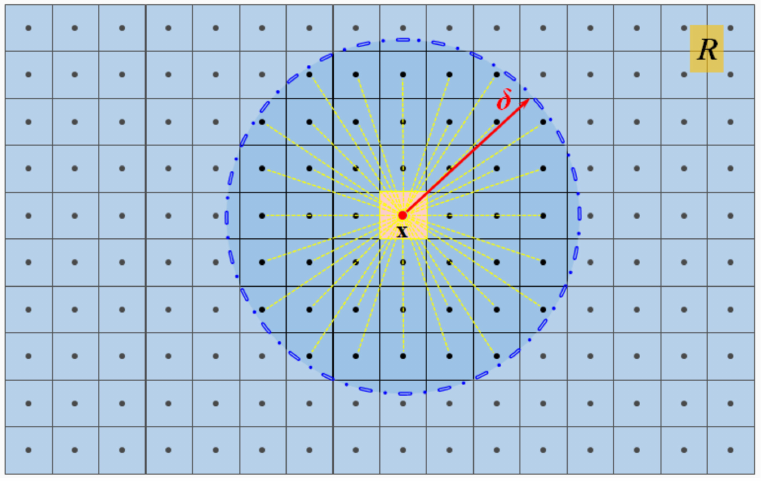
Figure 1. Peridynamics